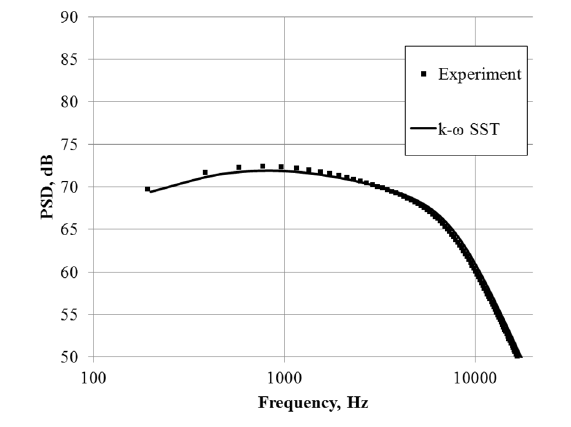
Fig. 11. Experimental PSD of the wall-pressure.